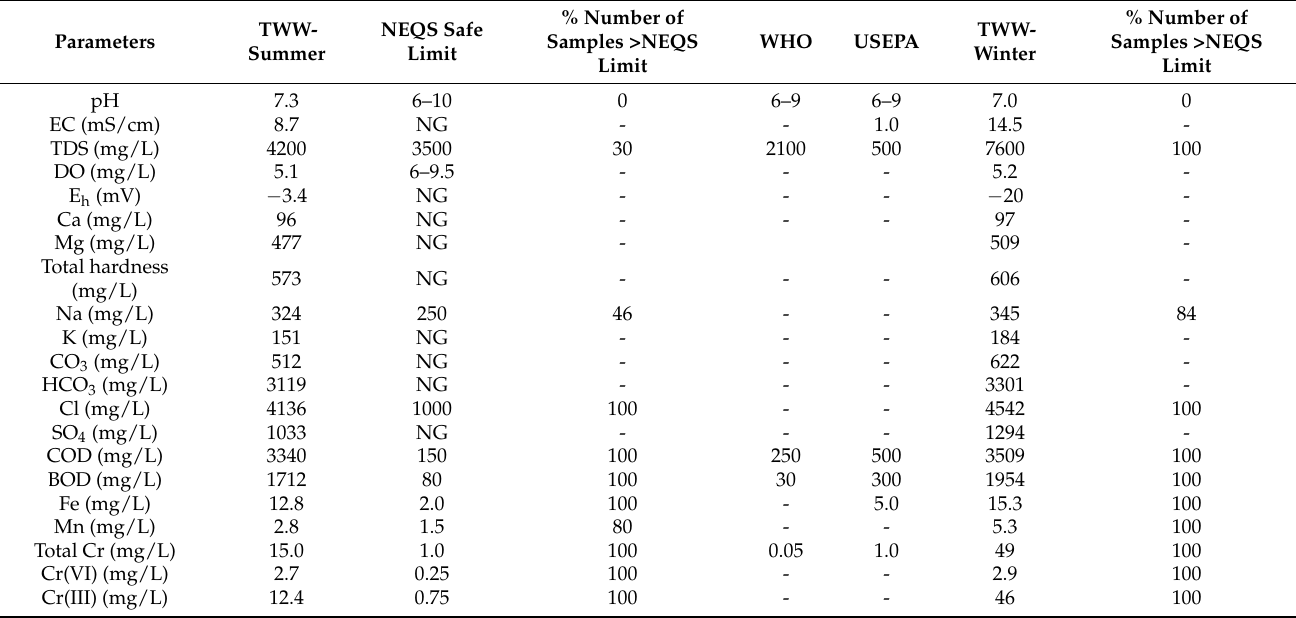
Table 2. Chromium concentration and maximum permissible limits for Cr and other wastewater quality parameters set by NEQS, WHO and